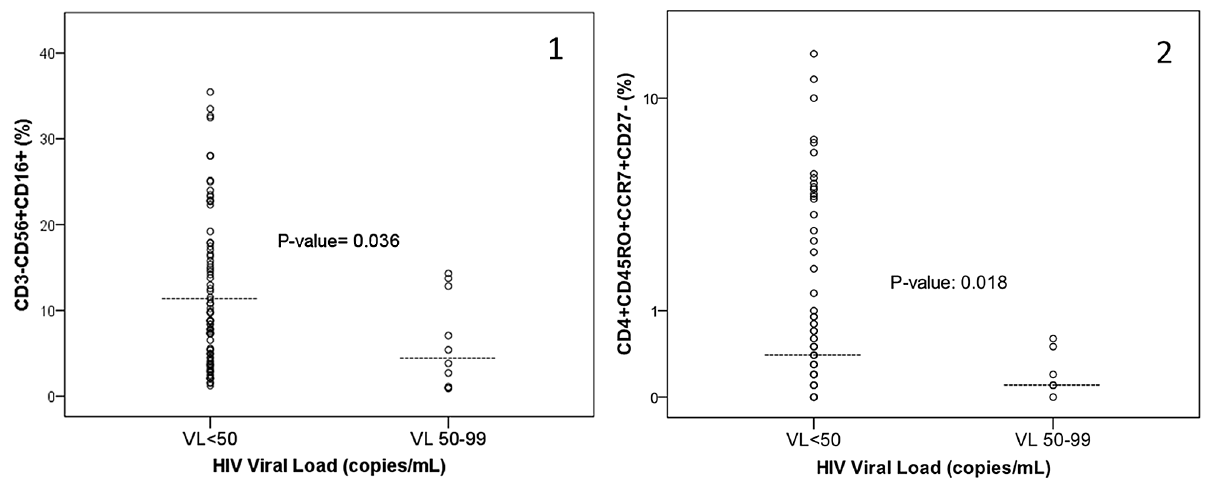
Figure 3. Comparison of NK cells and T cell populations based on HIV-1 viremia below and above 50 copies/mL. Figure 3 demonstrates that the population percentage of CD3-CD56 + CD16 + cells (panel 1) and CD4-CD45RO + CCR7 + CD27- cells (panel 2) were decreased in samples with HIV-1 RNA levels of 50–99 copies/mL as compared to samples obtained with HIV-1 RNA below 50 copies/mL with p-values of 0.036 and 0.018, respectively. The median level for each cell population is indicated by the line in the scatterplot for each group.